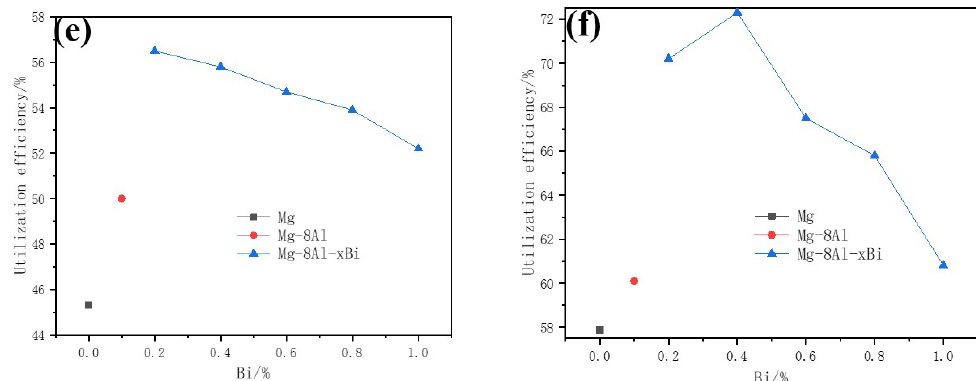
Figure 3. Discharge curves of Mg – 8%Al – xBi electrode with different Bi content at ( a ) 30 mA/cm 2 and ( b ) 120 mA/cm 2 ; Discharge potential – Bi content curves at ( c ) 30 mA/cm 2 and ( d ) 120 mA/cm 2 ; Utilization efficiency – Bi content curves of Mg – Bi alloy at ( e ) 30mA/cm 2 and ( f ) 120 mA/cm 2 , measured in 3.5% NaCl solution.